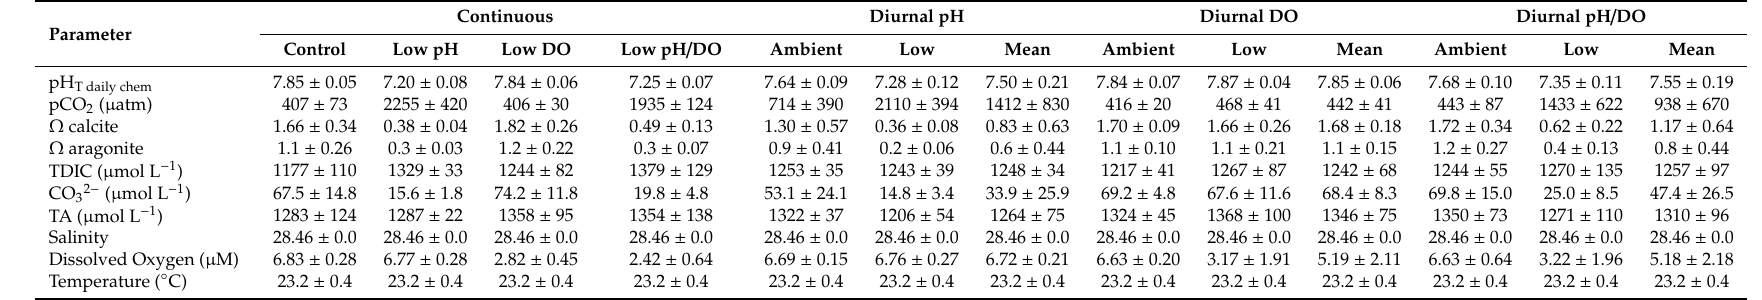
Table 2. Mean ( ± standard deviation) pH, pCO 2 , saturation states of calcite and aragonite, total dissolved inorganic carbon (TDIC), carbonate, total alkalinity (TA), salinity, dissolved oxygen, and temperature for the Menidia menidia seven treatment diurnal acidification and hypoxia experiments.